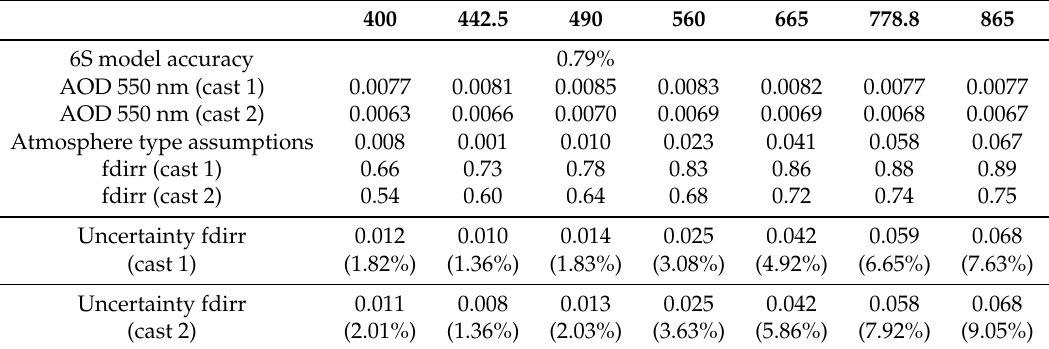
Table 3. Uncertainty components for the model, input data (AOD 550 nm) and assumptions relating to the atmosphere specified for each band of interest. All values, except model accuracy, are written in terms of the uncertainty applied to the output, f dirr